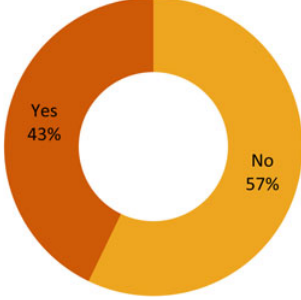
Fig. 10. Percentage of students who access support provided by